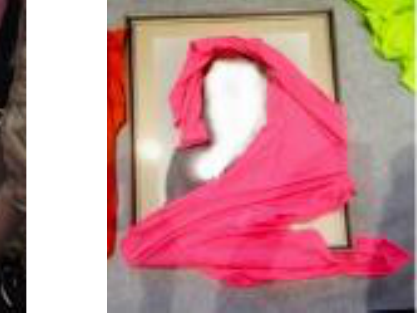
Figure 6 : Cloth draped around the